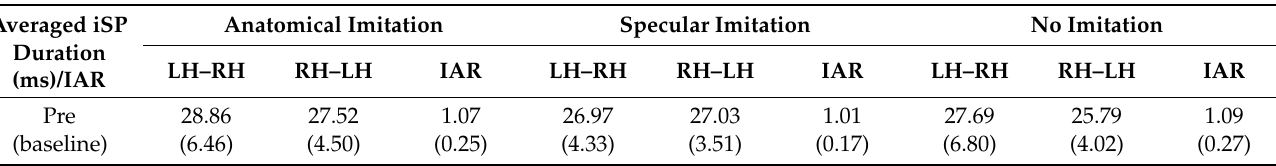
Table 1. Averaged values of all data analyzed. The standard deviation (SD) of each value was presented in parentheses. LH left hemisphere; RH, right hemisphere; iSP, ipsilateral silent period; IAR, interhemispheric asymmetry ratio; NDH, nondominant hand; DH, dominant hand; ∆ , variance compared to